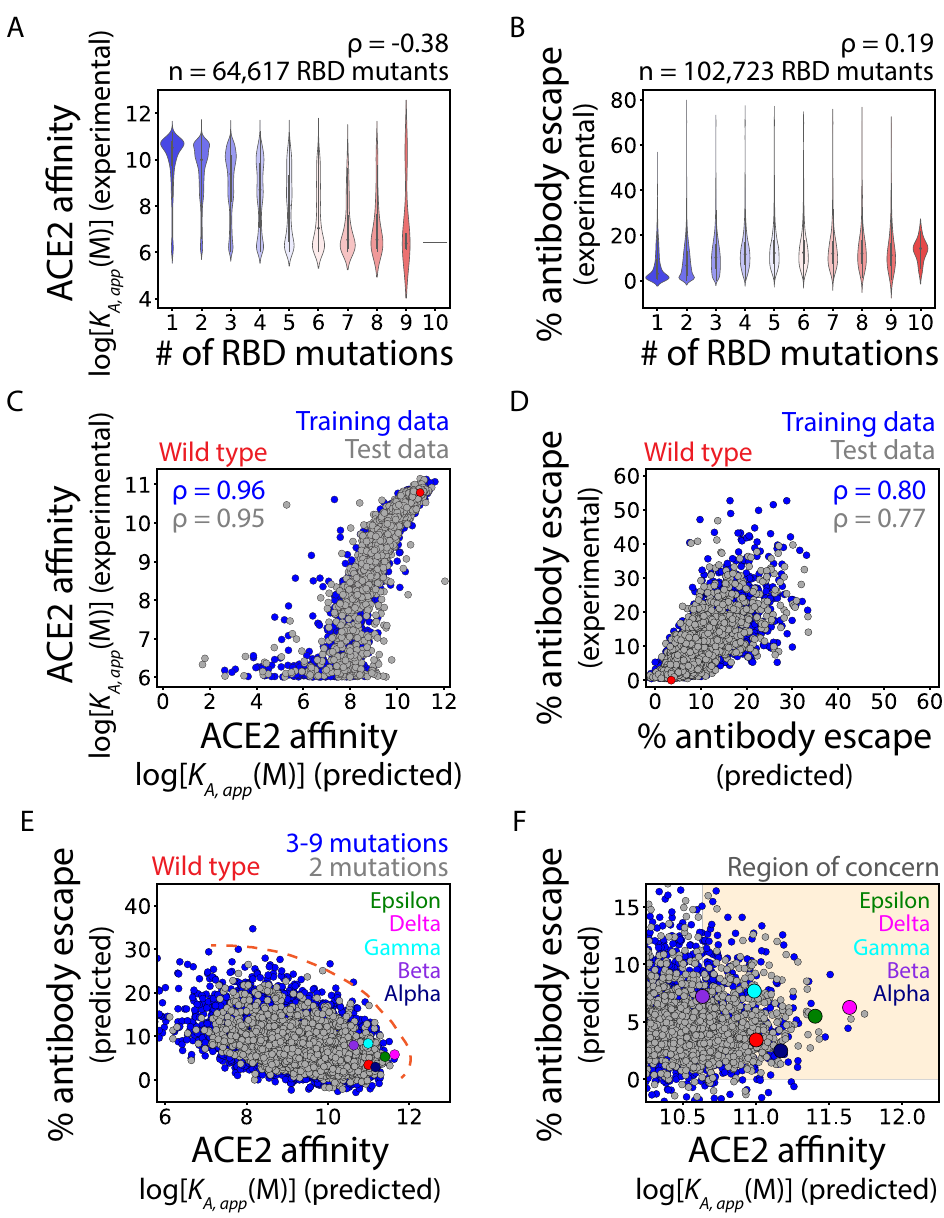
Fig 2. Machine learning models predict the impact of RBD mutations on ACE2 affinity and % human serum antibody escape, including for current and former CDC Variants of Concern. (A, B) Increasing numbers of RBD mutations generally (A) reduce ACE2 affinity and (B) increase % antibody escape. (C, D) Machine learning models predict the impact of RBD mutations on (C) ACE2 affinity and (D) % antibody escape for the training and test datasets with 1–10 RBD mutations. (E, F) The two models reveal natural tradeoffs between the impact of RBD mutations on ACE2 affinity and % antibody escape. The predictions for wild-type SARS-CoV-2 are highlighted in red, while the predicted values for VOCs are highlighted in different colors (see legend). In (A), (C) and (E-F), the ACE2 affinities are reported as log[ K A , app (M)] values and higher values reflect higher affinity. The affinities are apparent values because the experimental datasets were obtained using bivalent ACE2 (ACE2-Fc), which results in much higher apparent affinity than that observed for monovalent ACE2. In (A-D), Spearman’s ρ values are given. In (E), the Pareto frontier that corresponds to the maximal level of antibody escape at each ACE2 affinity is indicated by the hashed red line. In (F), the ‘Region of Concern’ is defined as ACE2 affinity predictions greater than that for the Beta variant and % human antibody escape predictions values > 0%. In (C-D), model performance metrics are averages of tenfold cross-validation. In (C-F), each plot shows a randomly selected subset of 5,000 RDB